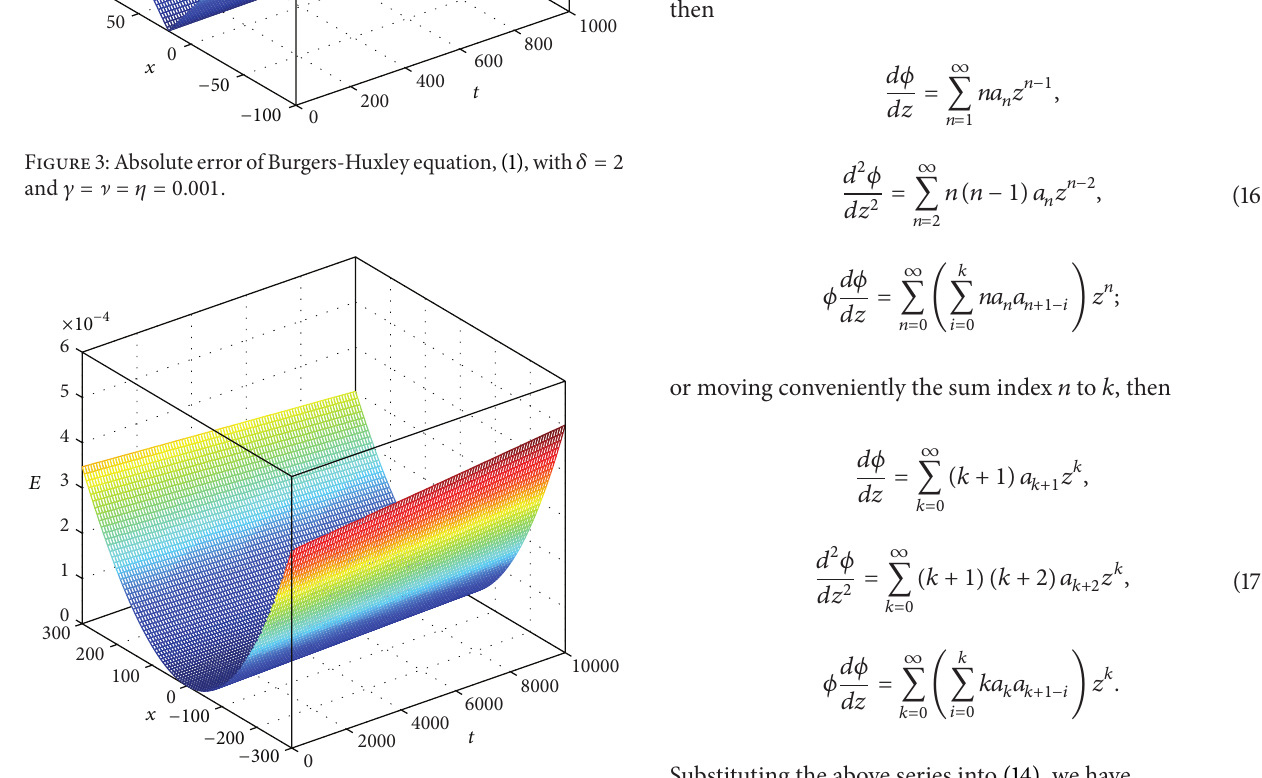
Figure4:AbsoluteerrorofBurgers-Huxleyequation, (1),with 𝛿 = 3 and 𝛾 = ] = 𝜂 = 0.001